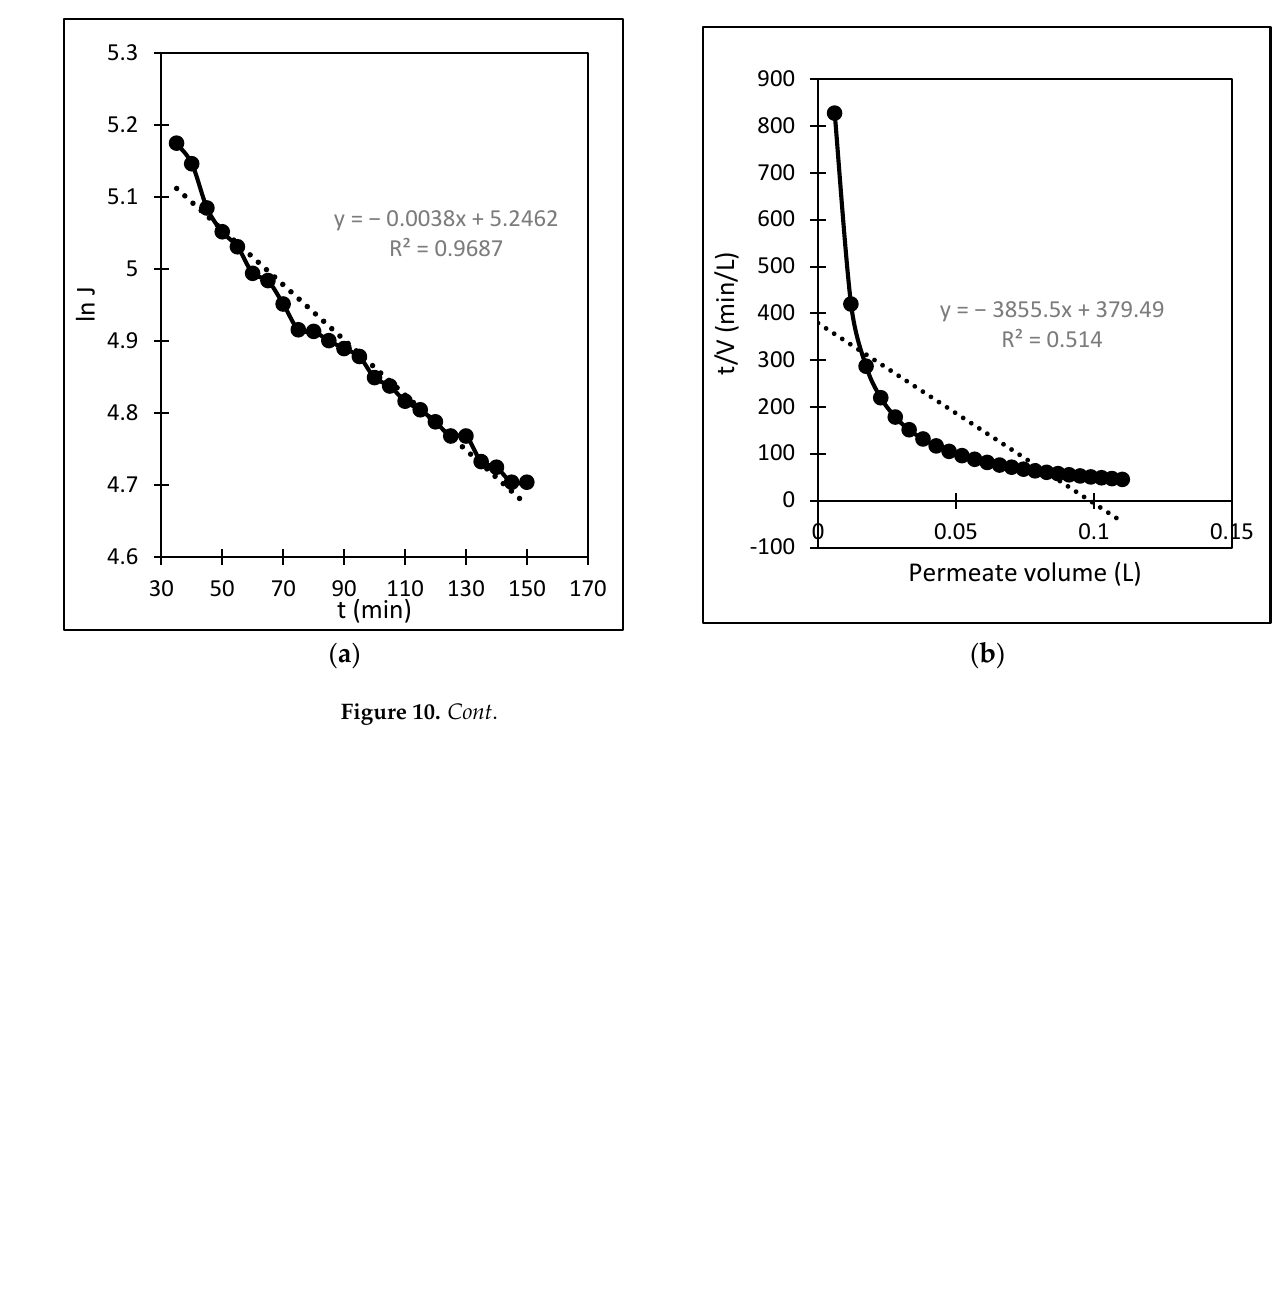
Figure 10. ( a ). Linearised graph representing complete blocking; ( b ) linearised graph representing cake fi ltration; ( c ) linearised graph representing standard blocking; and ( d ) linearised graph repre- senting intermediate blocking.